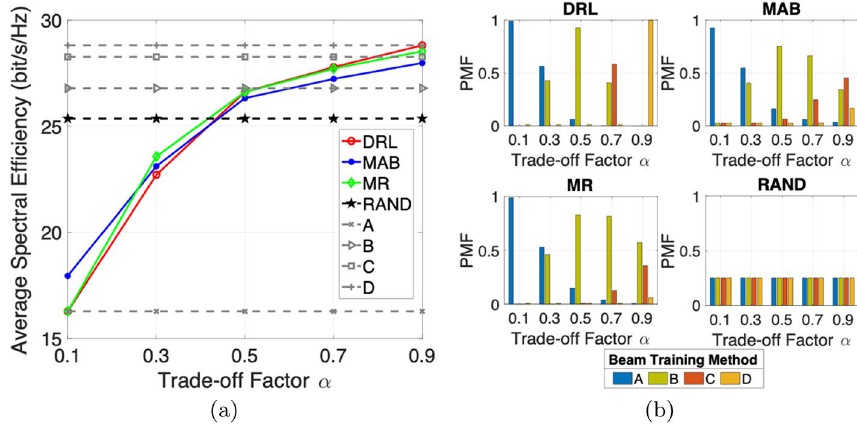
Fig. 9 Performance for different beam training policies with different trade-off factors α for DRL-SE. a Average SE v.s. α . b PMF of actions v.s. α